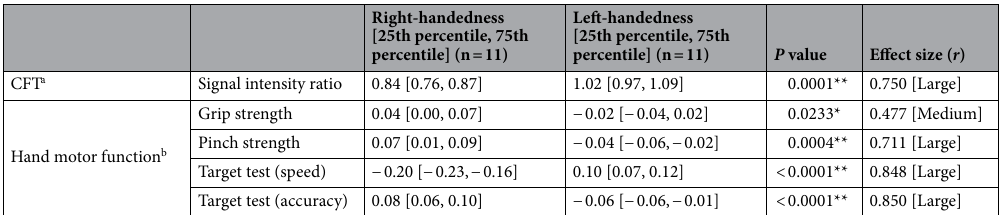
Table 2. The signal ratio of the CFT and the asymmetry index of hand motor function. a Ratio index is calculated as right CFT / left CFT. b Asymmetry index of hand motor performance = (right score − left score)/ (right score + left score). * P < 0.05, ** P <